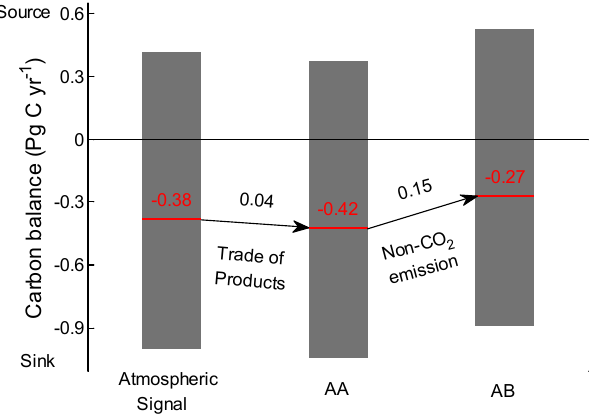
Fig. 7. Atmospheric inversion model estimated carbon balance in East Asia through considering lateral carbon fluxes. The same fos- sil fuel CO 2 emission estimate has been removed from each inver- sion to obtain the land–atmosphere CO 2 flux. The average of seven inverse model estimations (atmospheric signal) is corrected by two lateral fluxes. (1) CO 2 emissions due to imported wood and food products (0.04PgCyr − 1 ) are added to the atmospheric inversion result, resulting in AA; (2) the carbon sink in AA is reduced by car- bon fixed by photosynthesis but released to the atmosphere by non- CO 2 compounds (0.15PgCyr − 1 ) , including CO, CH 4 and volatile organic compounds (VOCs), resulting in AB, which should be com- parable to estimates by the inventory- and satellite-based approach. Grey bars show ranges in the estimates by different inverse